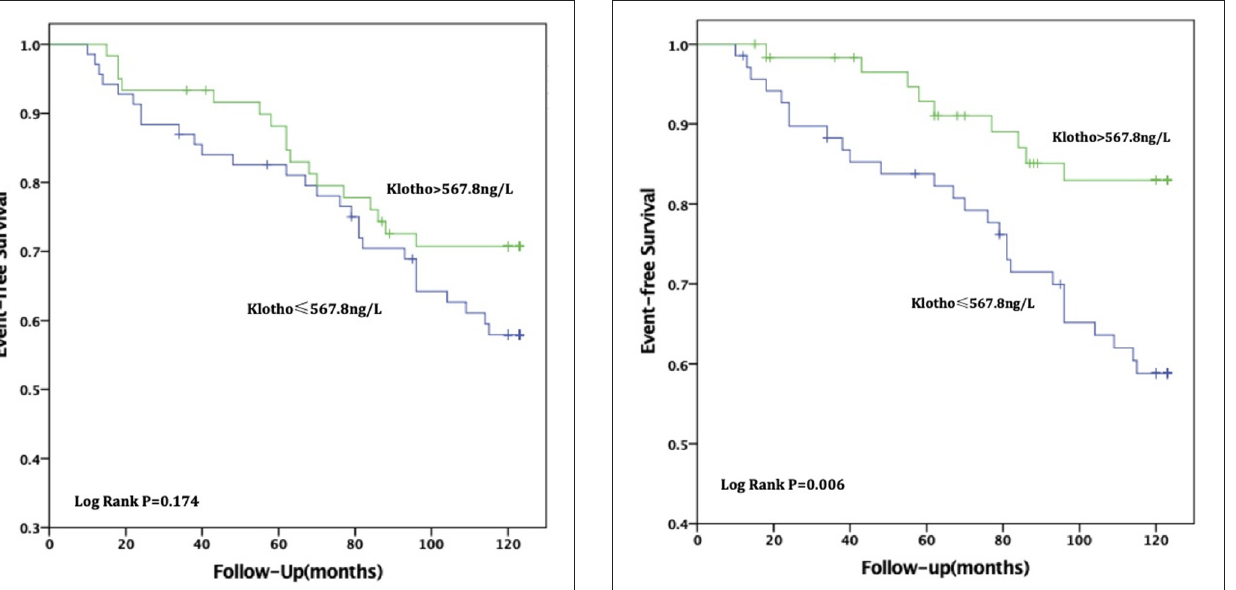
FIGURE 2 | Relationship between soluble Klotho level and all-cause mortality in MHD patients. For all-cause death, patients in high soluble Klotho level (sKl > 567.8 ng/L) had a higher survival time than in the low soluble Klotho level (sKl ≤ 567.8 ng/L). But Kaplan-Meier analysis with log-rank test revealed no significant difference between groups ( P = 0.174).